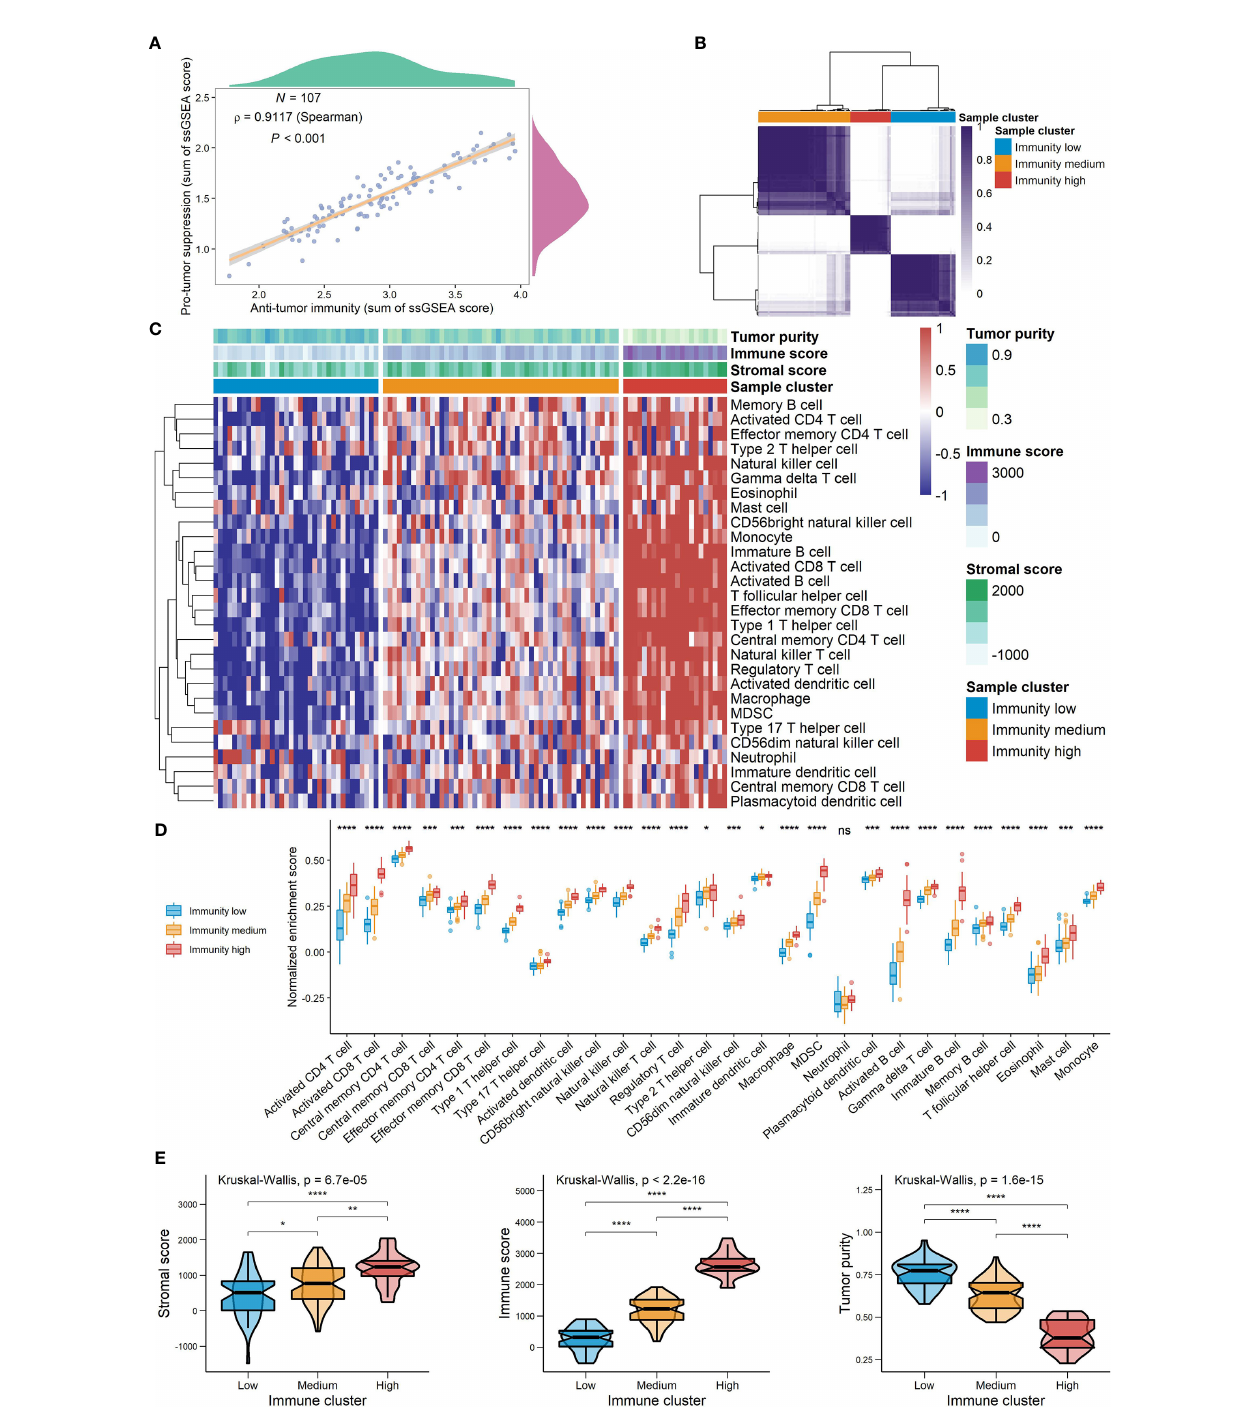
FIGURE 8 | The landscape of TME signatures in the GSE58812 cohort. (A) Correlations between in fi ltration of cell types executing anti-tumor immunity and cell types executing pro-tumor, immune suppressive functions. The correlation coef fi cient ( r ) is generated by Spearman ’ s correlation. The shaded area represents 95% con fi dent interval. (B) Consensus clustering of TNBC patients based on tumor-in fi ltrating immune cells to classify patients into three groups. (C) Unsupervised clustering of TNBC microenvironment phenotypes. Rows represent tumor-in fi ltrating immune cells and columns represent samples. (D) The relative abundance of tumor-in fi ltrating immune cells in the three immune clusters. (E) A comparison of stromal score, immune score and tumor purity among the three clusters (*0.01 < P < 0.05; **0.001 < P < 0.01; ***0.0001 < P < 0.001; **** P < 0.0001; ns, P >